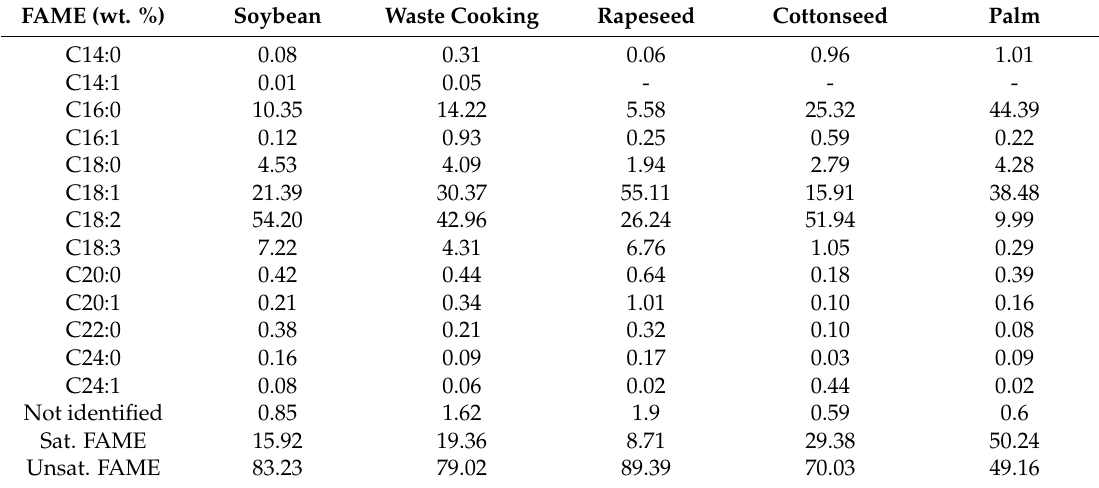
Table 2. Fatty acid methyl ester (FAME) compositions of BD